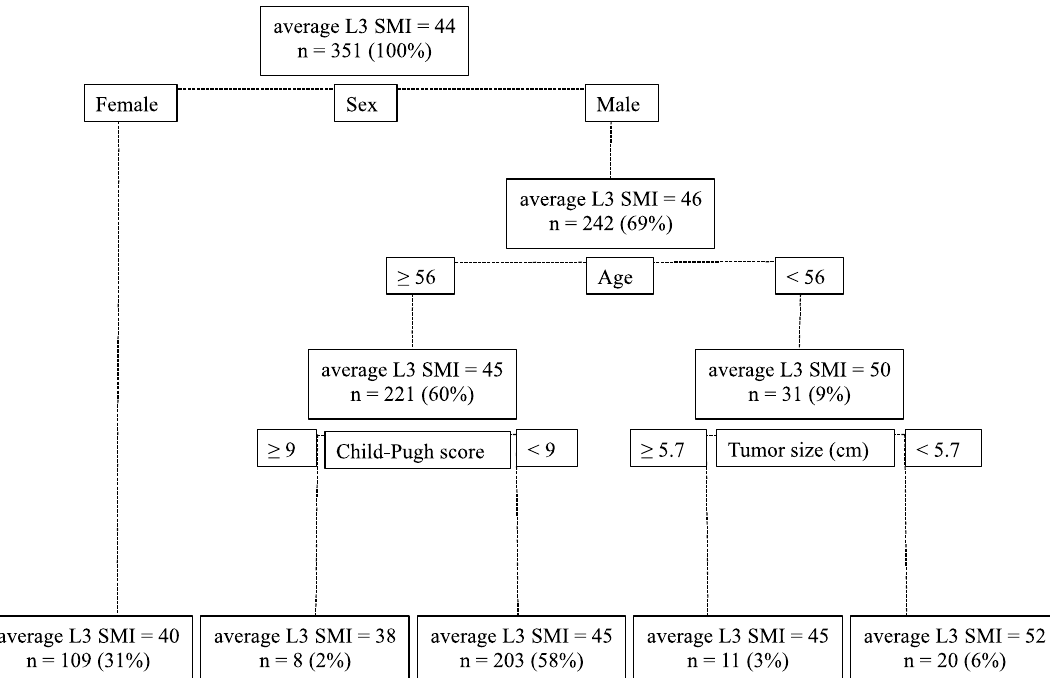
Figure 2. The decision tree for the tree-based models. The differences in L3 SMI between each group become larger with the six factors (age, sex, Child–Pugh score, maximum tumor size, tumor number, and the degree of portal vein invasion).